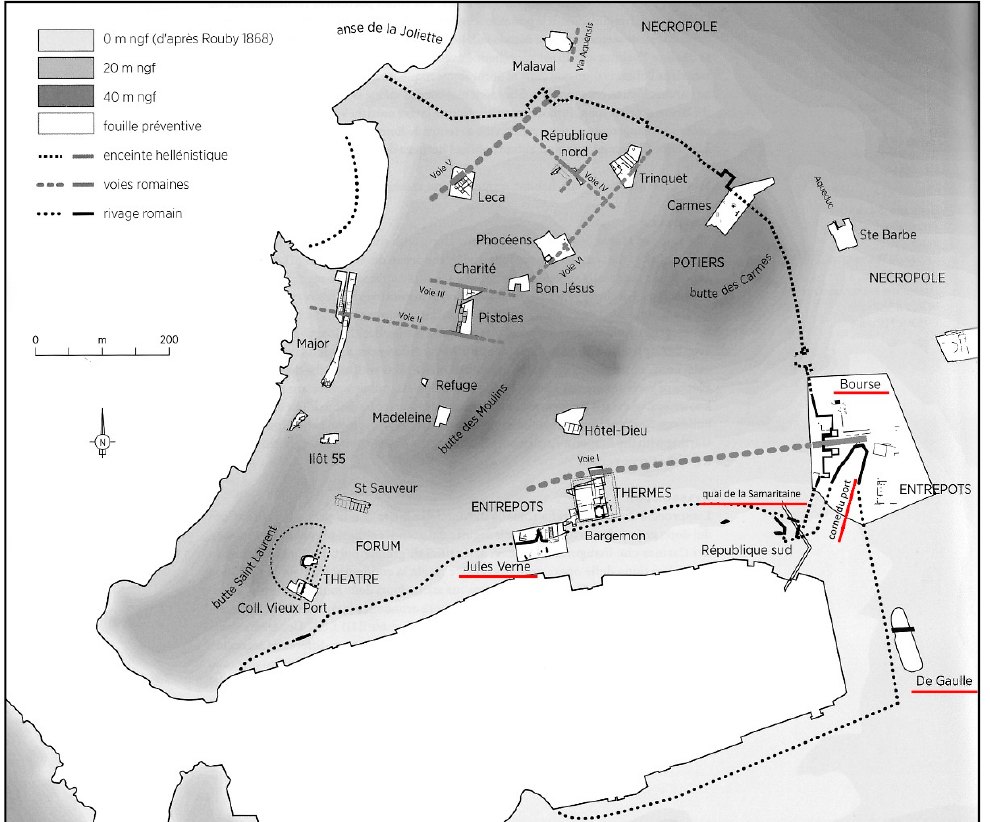
Figure 3. Plan of Marseille with the most important sites mentioned in the text (after B. Sillano [23] (Figure